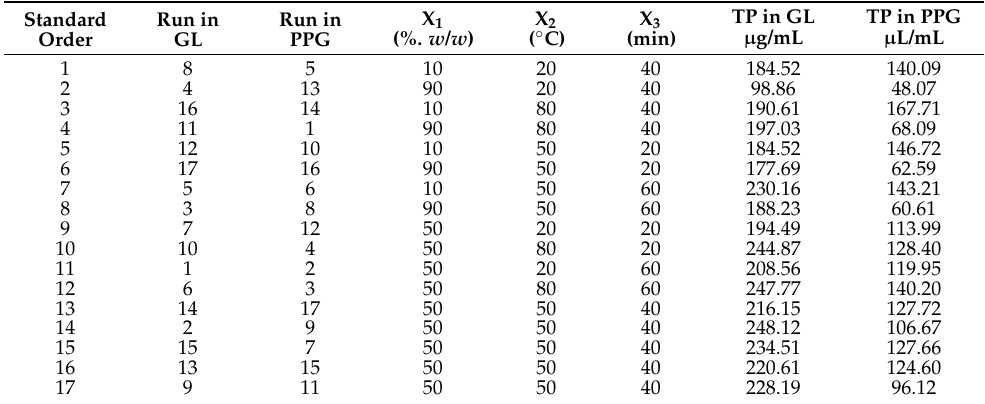
Table 2. The Box Behnken design and content of total phenols (TP) in the extracts in glycerol (GL) and polypropylene glycol (PPG) extraction. Standard Order